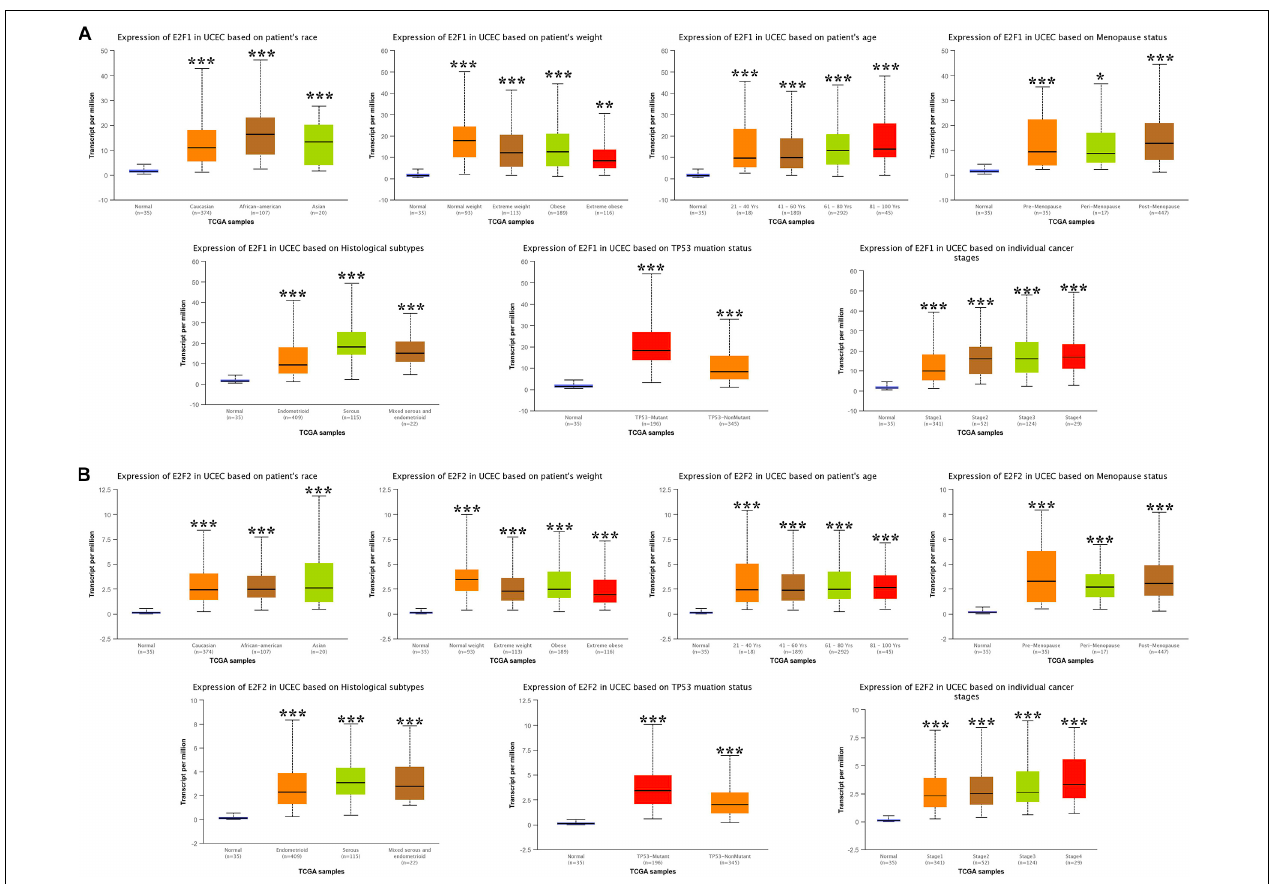
FIGURE 4 | The level of E2F1 and E2F2 in UCEC. (A) E2F1 expression in multiple subgroups of patients with UCEC (race, weight, age, menopause status, histological subtypes, TP53 mutation status, and cancer stage). (B) Expression of E2F2 in multiple subgroups of patients with UCEC. Stratified based on race, weight, age, menopause status, histological subtypes, TP53 mutation status and cancer stage. * P < 0.05; ** P < 0.01; *** P < 0.001).